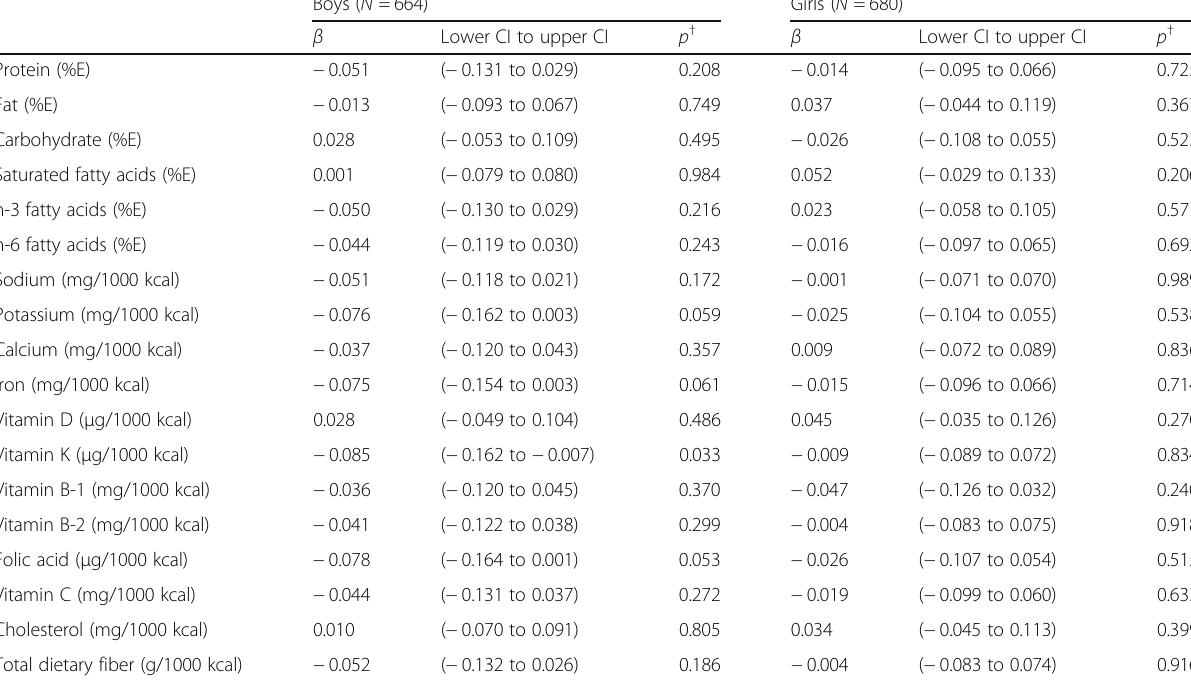
Table 6 The relationship between personal computer using and nutrient